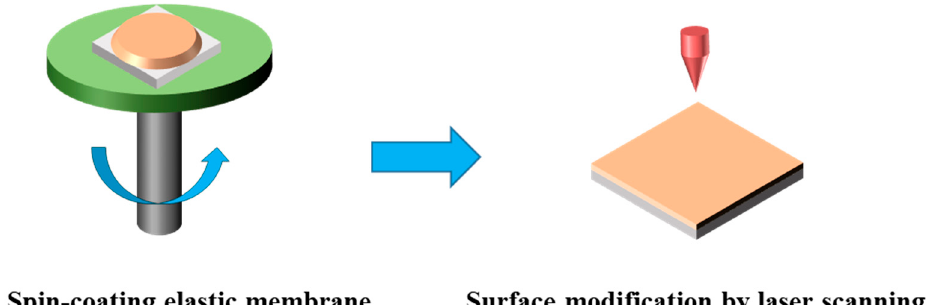
Figure 1. Fabrication of Polydimethylsiloxane (PDMS) elastic superhydrophobic membrane.